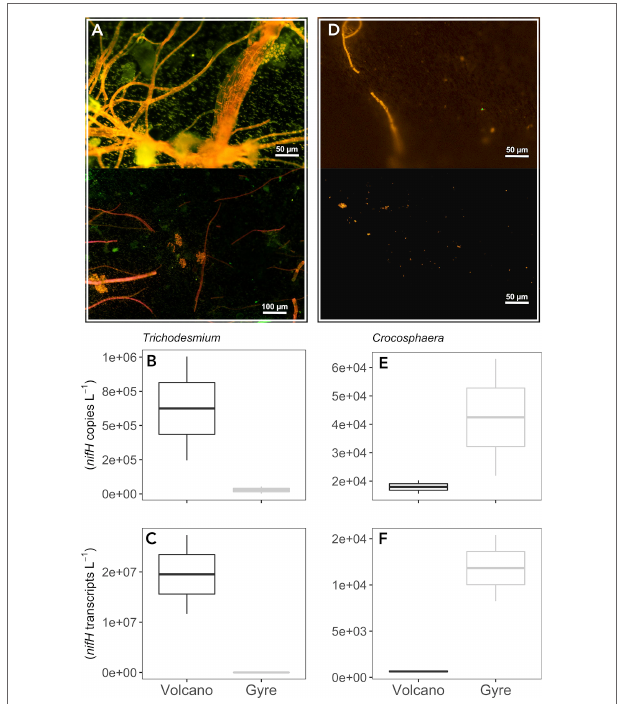
FIGURE 1 | Epifluorescence microscopy images from the time zero samples inspected before NanoSIMS analysis showing main diazotrophic communities at the volcano (A) and at the gyre station (D) . Boxplots represent average nifH abundances and transcripts of Trichodesmium (B, C) and Crocosphaera (E, F) from duplicate time zero samples measured by qPCR in triplicate at each